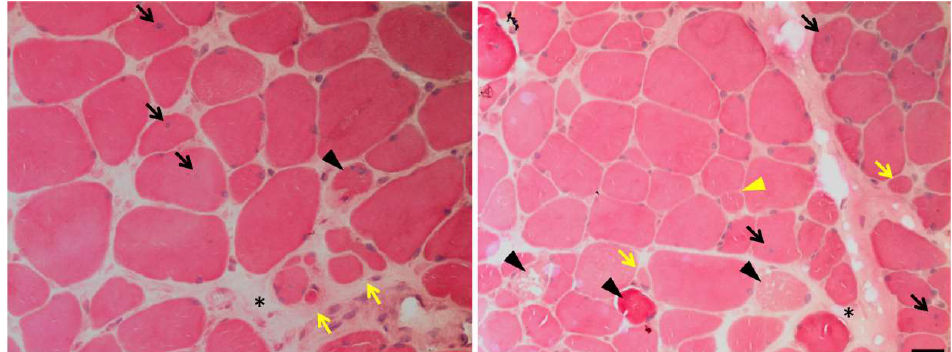
Figure 3. Muscle biopsy of a LGMDR1 patient. Hematoxylin and eosin staining shows endomysial fibrosis (black asterisks), central nuclei (black arrows), fiber splitting (yellow triangle), necrosis (black triangles), atrophic fibers (yellow arrows) and increased variation in fiber size and shape. Scale bar: 25 µm.